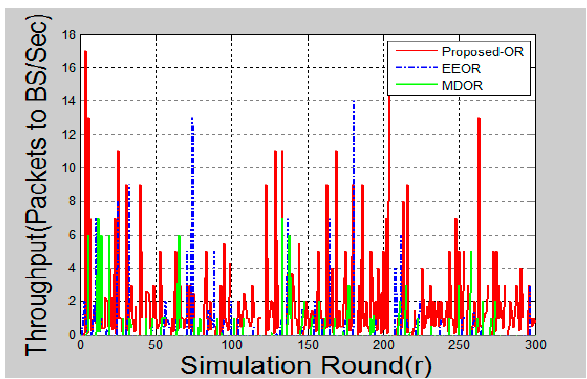
Figure 7. Packet to Base Station per Second.